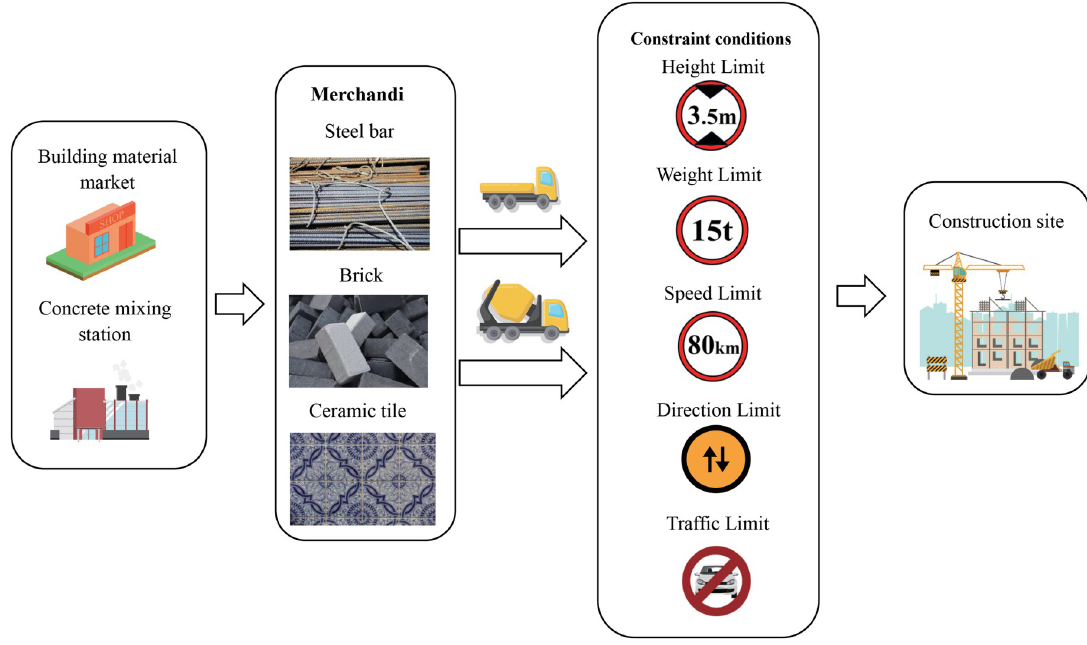
Fig 1. Constraint